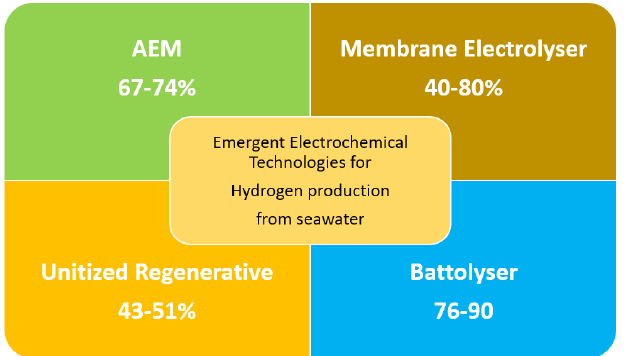
Figure 5. Efficiency of emergent electrochemical technologies suitable for hydrogen production from seawater.